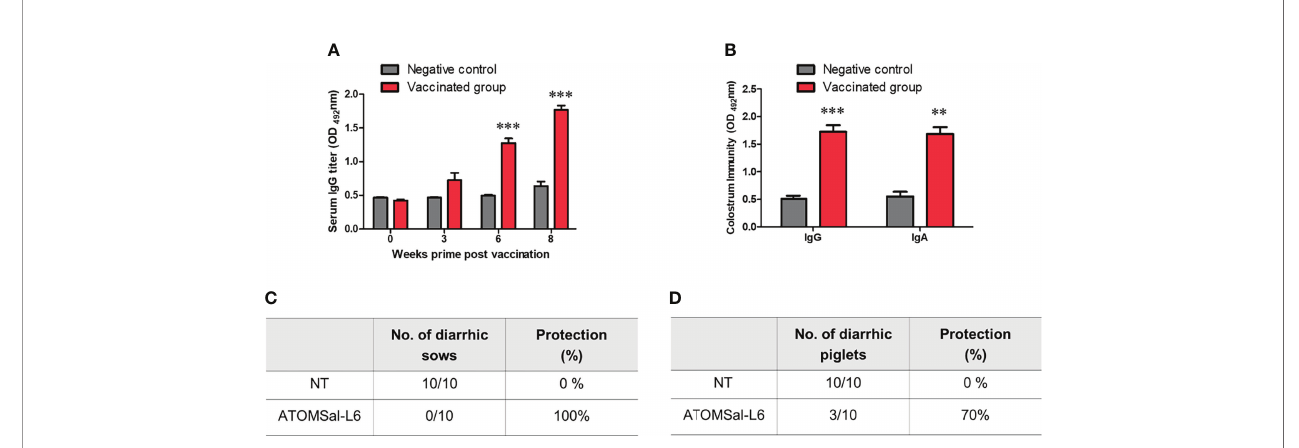
FIGURE 6 | Analysis of humoral immune responses induced by immunization of ATOMSal-L6 in swine. Pregnant sows (n = 3 per group) were immunized orally with 2 × 10 9 CFU of ATOMSal-L6 twice at three-week intervals. Sera were collected two weeks after the vaccination and colostrum was collected on day of delivery. (A) ST-speci fi c serum IgG and (B) ST-speci fi c colostrum IgG and IgA were measured using ELISA. (C) Sows (n = 10/group; left panel) and (D) piglets (n=10/group; right panel) born from vaccinated sows were orally challenged with 5 × 10 8 CFU of ST WT and monitored for diarrhea symptoms and survival for 14 days. **P < 0.01, ***P < 0.001, compared to unvaccinated